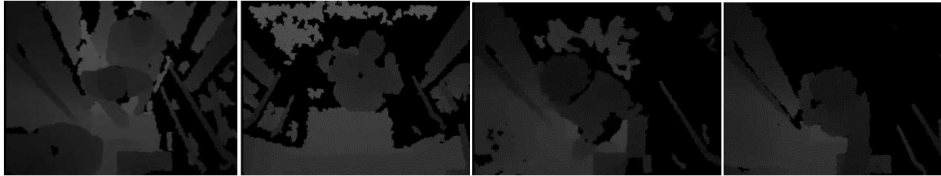
Figure 12. Video frame examples of the PCDS